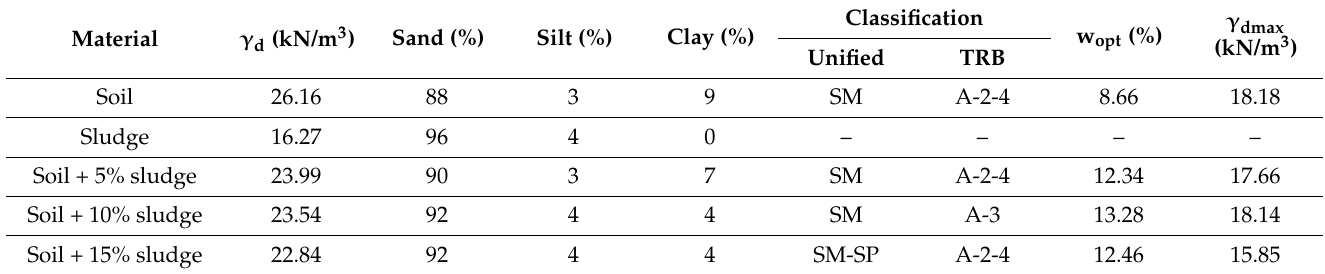
Table 2. Dry unit weight ( γ d ), percentage of sand, silt, and clay in the materials analyzed and physical